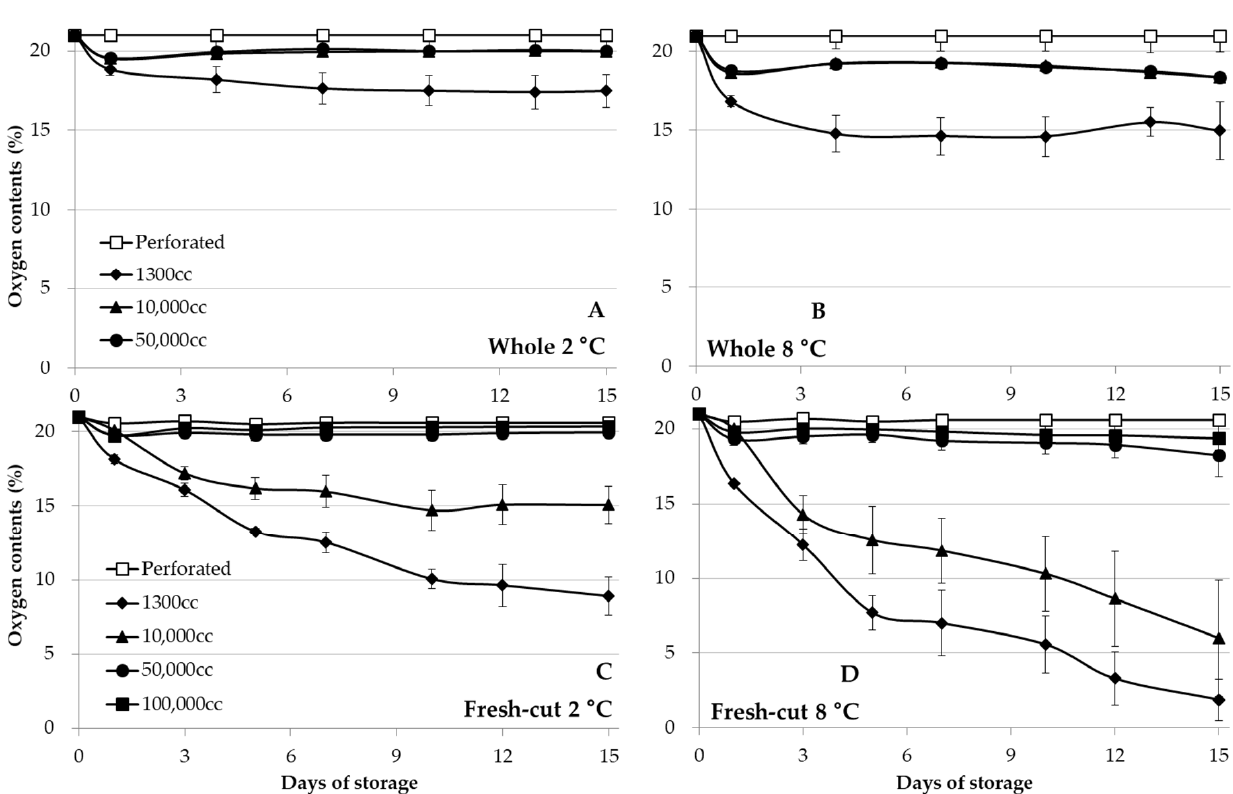
Figure 1. The oxygen contents of whole ( A : 2°C and B : 8°C) and fresh-cut ( C : 2°C and D : 8°C) romaine lettuce in OTR film (1300 cc; 10,000 cc; 50,000 cc; 100,000 cc·m − 2 ·day − 1 ·atm − 1 ) in MA storage at 2 and 8 °C for 15 days. Vertical bars represent ±SD of the means ( n = 5).